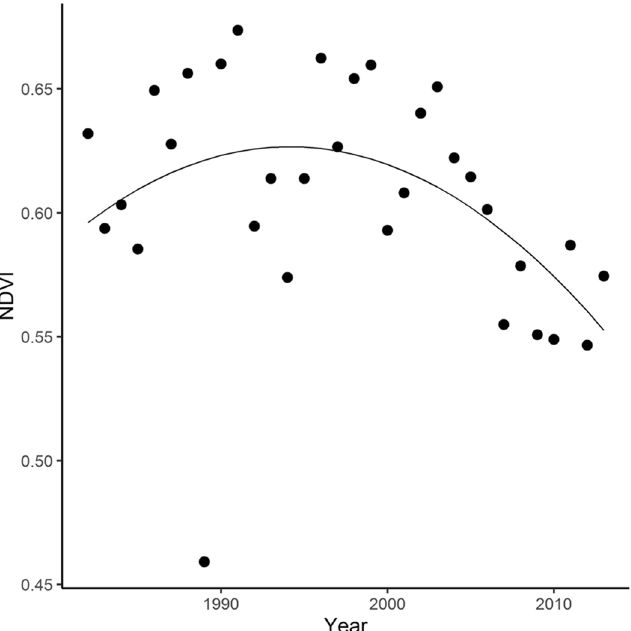
Figure 2. Temporal trend in NDVI extracted from the previously defined wintering areas during the period 1981–2013 (pixels that were assigned to be the likely origin for > 60% of our sample; see Figure. 1H). Points represent average NDVI from November (year “i-1”) to March (year “i”). Average NDVI values were obtained from bimonthly data developed by ECOCAST (available at https:// ecoca st. arc. nasa. gov/ data/ pub/ gimms/ 3g. v0/). The continuous line indicates the predicted NDVI values given by the linear model fitted with NDVI as a function of year and second degree of year using Ordinal Least Squares.